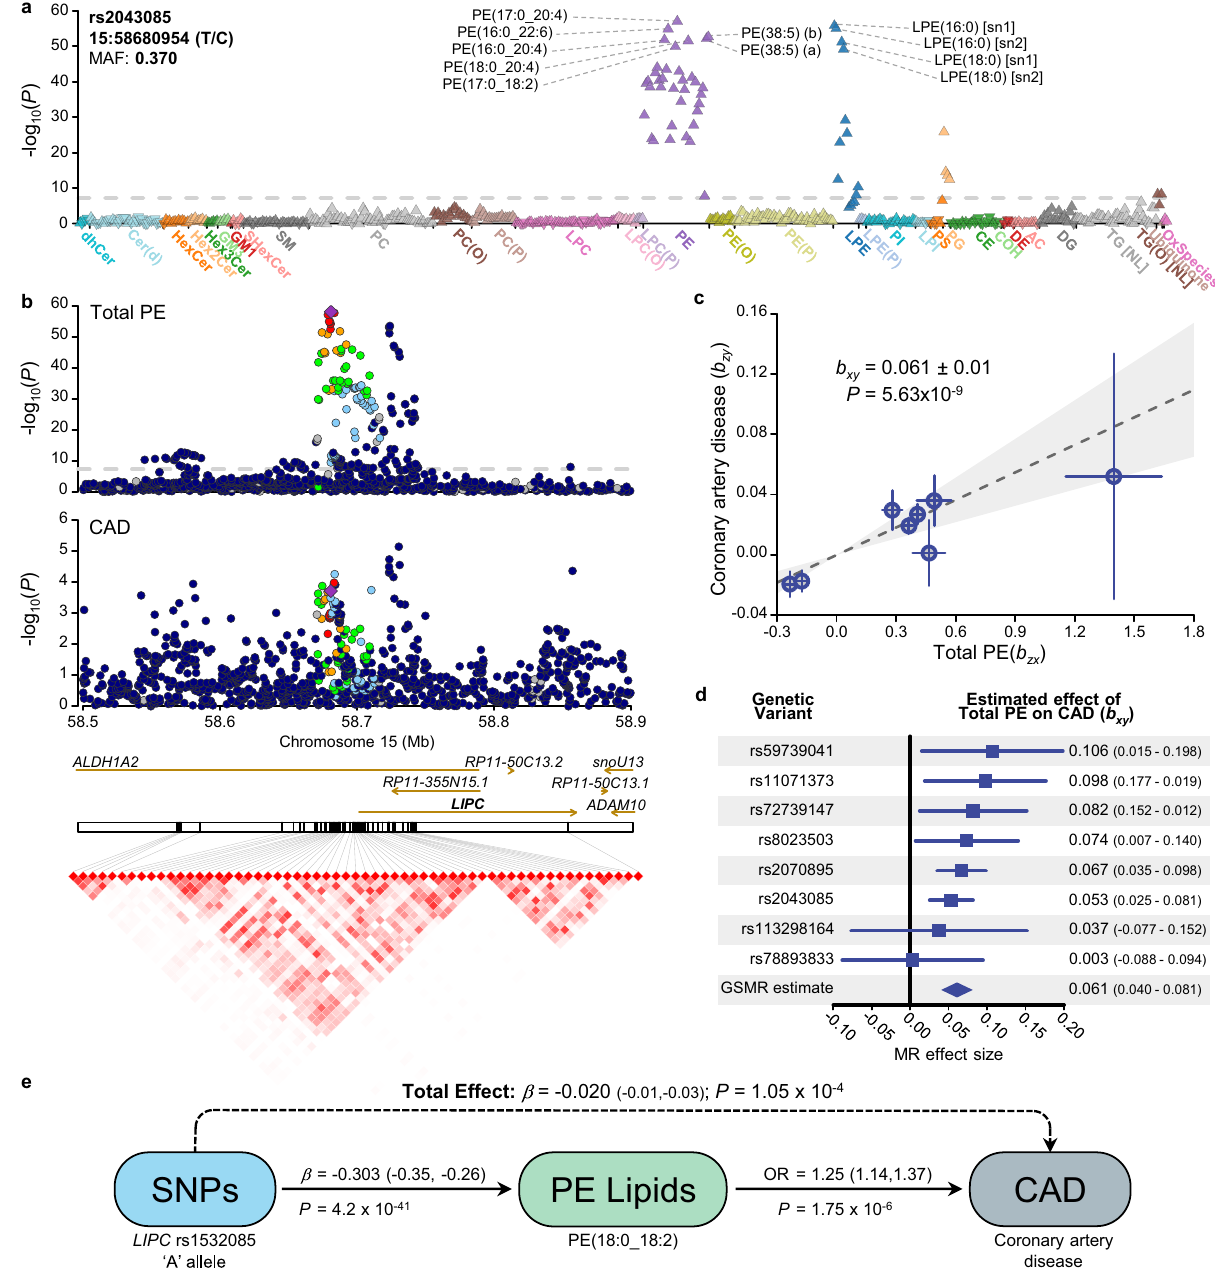
Fig. 7 Genetic analysis of the LIPC gene region and circulating levels of phosphatidylethanolamine. a Lipid-wide association with the genetic variant, rs2043085, in the BHS cohort ( n = 4492). Symbol colour is used to distinguish lipid classes. The symbol orientation indicates the effect sign, inverted triangles indicate negative associations, while regular triangles indicate positive associations. The dashed line indicates genome-wide signi fi cance ( P < 5 × 10 − 8 ). b Regional association plots for Total PE and coronary artery disease (van der Harst & Verweij 2018), focusing on the LIPC region. Variants are coloured based on LD with the lead variant, rs2043085. Linkage disequilibrium plot showing correlation between variants following clumping ( r 2 > 0.8; P < 5 × 10 − 8 ). Variant correlations were obtained from 10,000 unrelated individuals from the UK Biobank. c Plot of genetic instrument effect sizes against Total PE ( n = 4492) and coronary artery disease ( n = 547,261). Variants were selected based on association with Total PE from within the LIPC region. Eight approximately independent variants were left following clumping ( r 2 > 0.05; P < 5 × 10 − 8 ). Generalised Summary-data based Mendelian Randomisation (GSMR) was used to estimate effect of Total PE on coronary artery disease, accounting for the variant correlations and uncertainty in both b zx and b zy . Data are presented as mean ± SE. d Forest plot of single variant tests and GSMR estimates from panel c. Data presented as mean ± 95% con fi dence interval. e Diagram of mediated pleiotropy, showing effect sizes estimated across multiple datasets. Exposure modifying variant effect sizes were estimated in the BHS cohort, as well as odds ratio of phosphatidylethanolamine lipid species against incident cardiovascular disease. Total effect represents the sum of genetics effects on coronary artery disease, whether mediated through phosphatidylethanolamine or not. Coronary artery disease effect size was obtained from van der Harst & Verweij 2018. Source data are provided as a Source Data fi le. MAF minor allele frequency, MR Mendelian randomisation, OR odds ratio, PE phosphatidylethanolamine, SNP single nucleotide